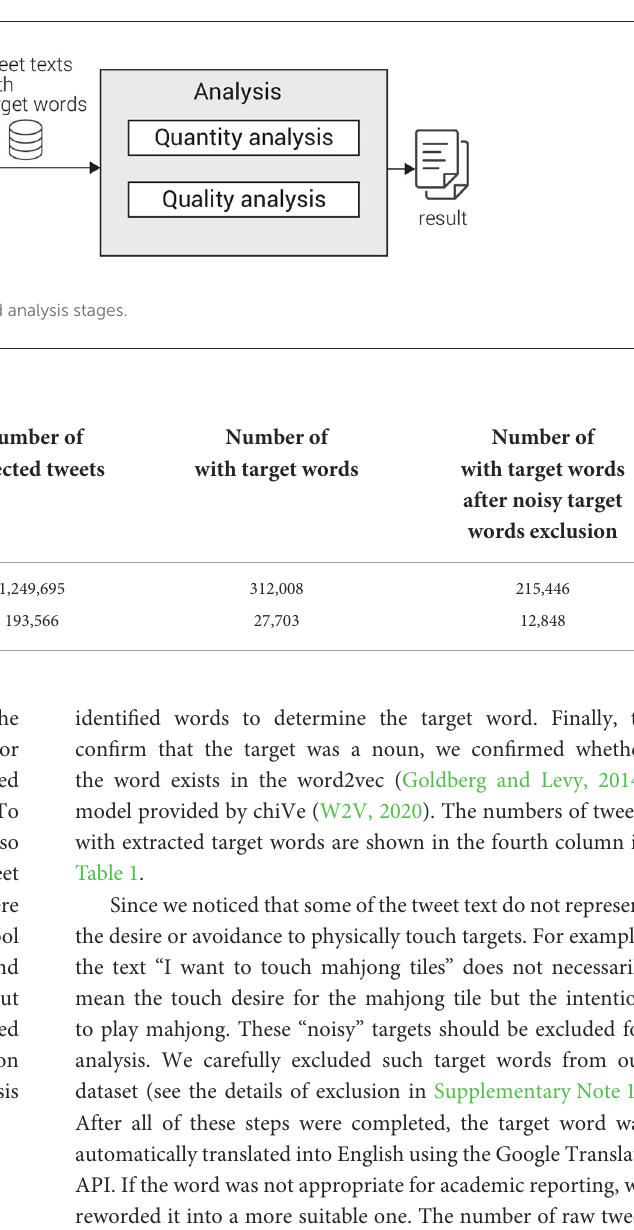
FIGURE1 The flow of investigation comprises collection, preprocessing, and analysis stages.